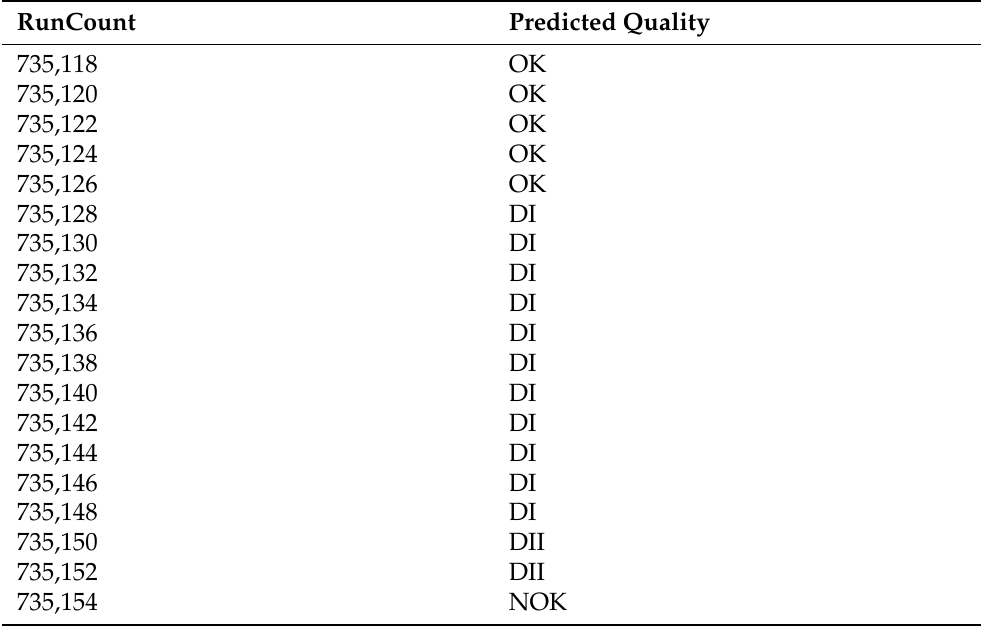
Table 10. Predictions received during the execution of the demonstration